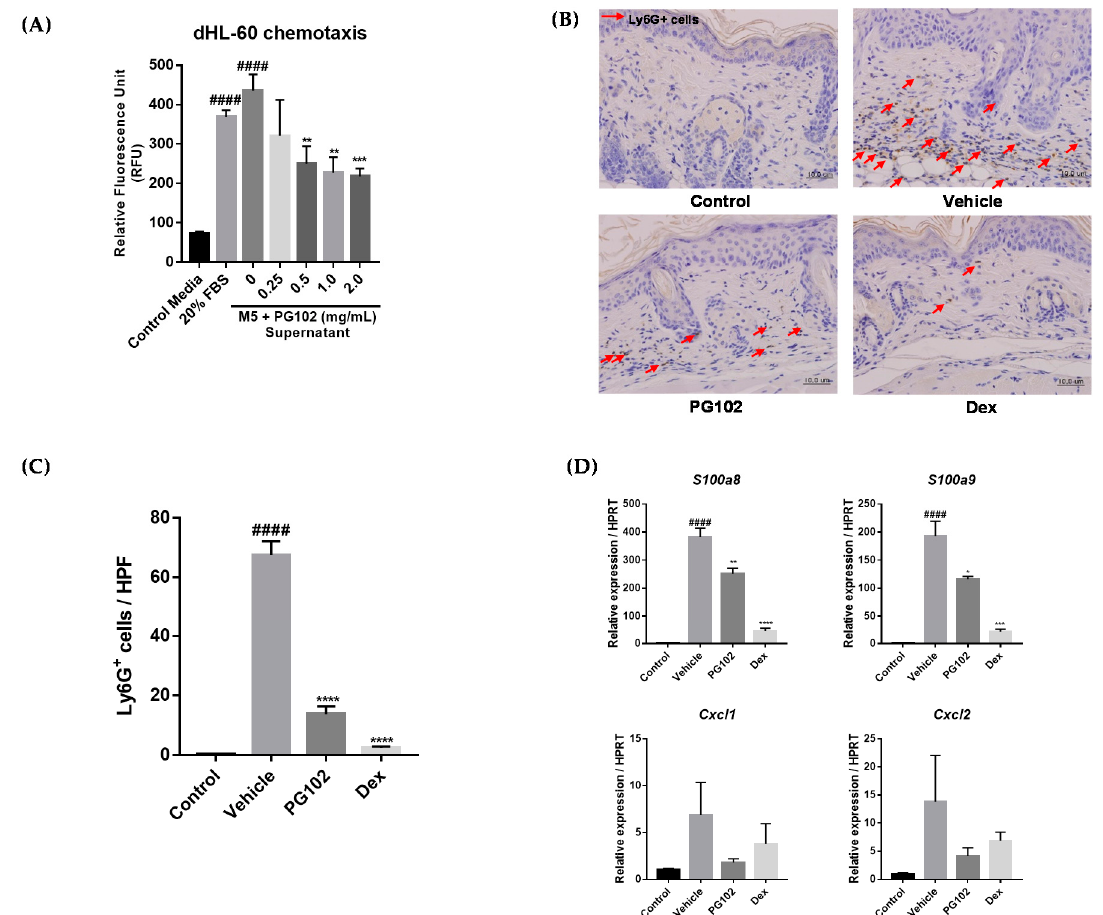
Figure 7. PG102 suppresses neutrophil chemotaxis in vitro and in vivo. ( A ) Chemotaxis assay of differentiated HL-60 (dHL-60) cells. ( B ) IHC staining for Ly6G in dorsal skin of control, vehicle, PG102 (100 mg/kg), Dex (1 mg/kg) treated mice. ( C ) Quantification of Ly6G+ cells per five random high power fields (400X). ( D ) Real-time qPCR analysis of mRNA expression levels of antimicrobial peptides and chemokines in dorsal skin of mice ( n = 3–4). FBS, fetal bovine serum; Dex, dexamethasone; M5, mixture of 5 cytokines. The data are shown as the mean ± SEM. #### p < 0.0001 versus Control group; * p < 0.05, ** p < 0.01, *** p < 0.001, **** p < 0.0001 versus vehicle group.